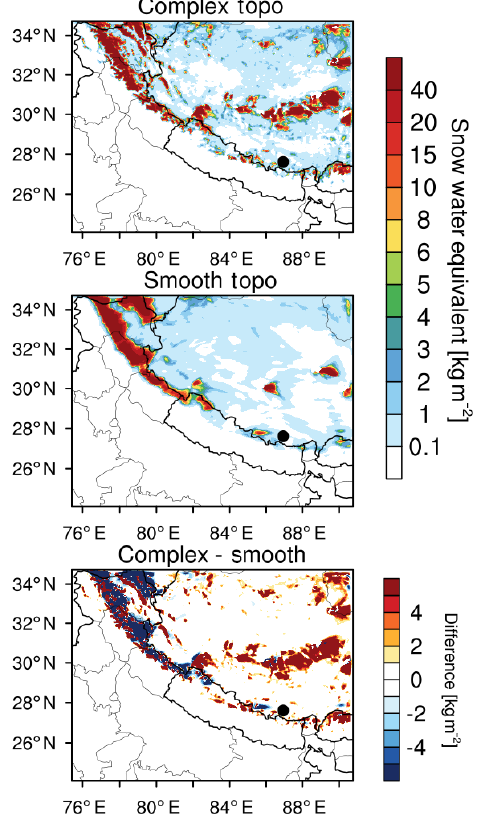
Figure 17. Spatial distributions of BC radiative forcing in the sur- face snow averaged for 1–20 April 2016 from the simulations with the complex and smooth topographies. The difference between the two is also